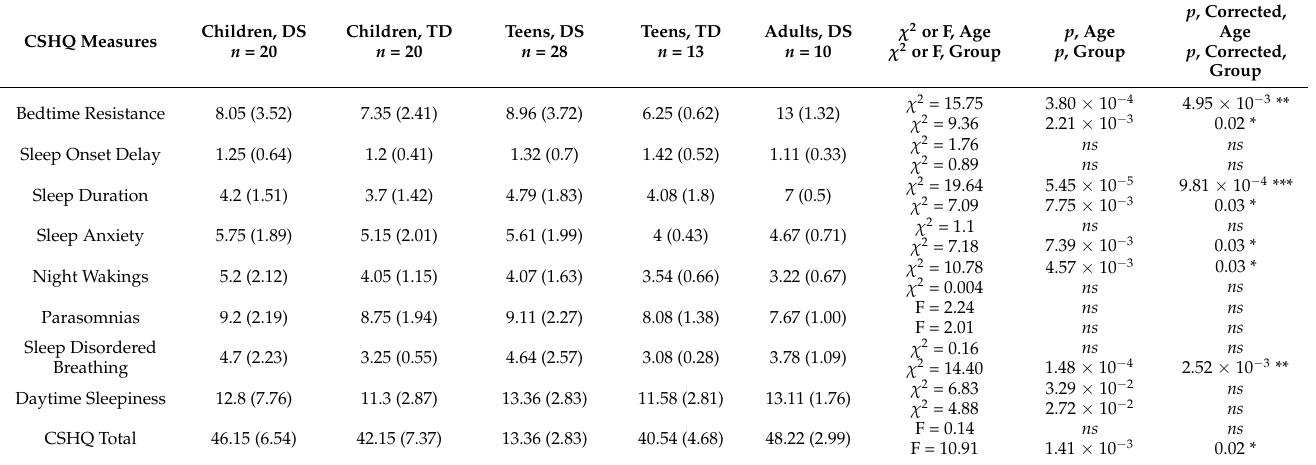
Table 3. ANOVA results for CSHQ domains; individuals with DS and with TD over 3 age groups: children 6–10, adolescents 11–18, and young adults